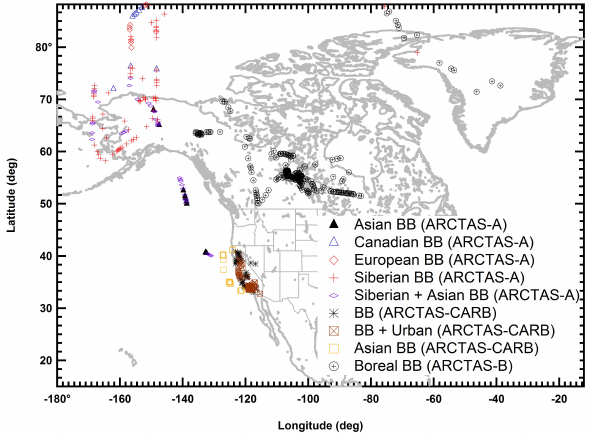
Fig. 1. Location of 495 biomass burning plumes recorded during the ARCTAS-2008 experiment aboard the DC-8 aircraft identified by fire source categories based on air mass backward trajectory analy-